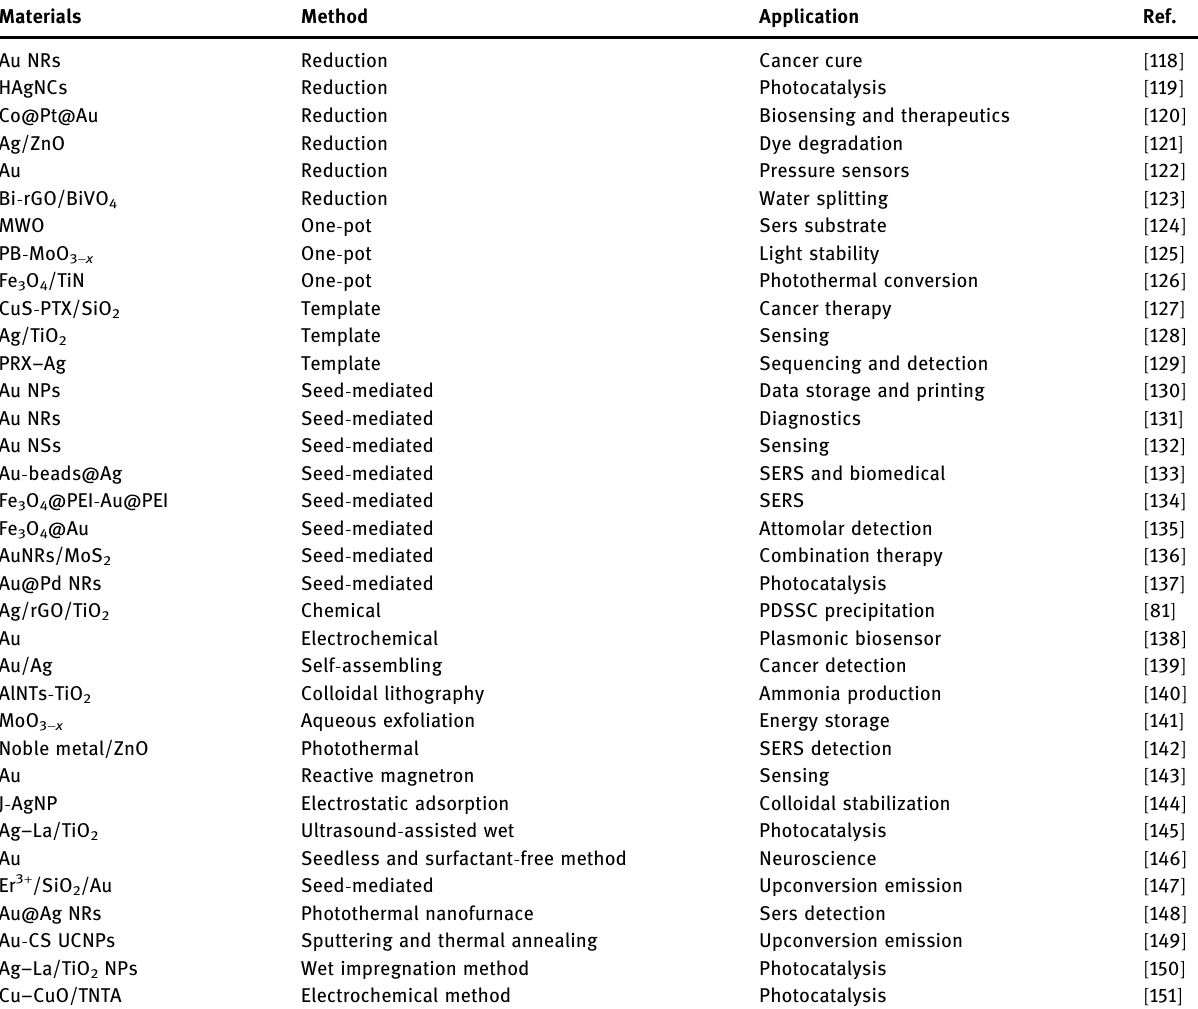
Table 1: Summary of metal - based P - NMs on synthetic method and application